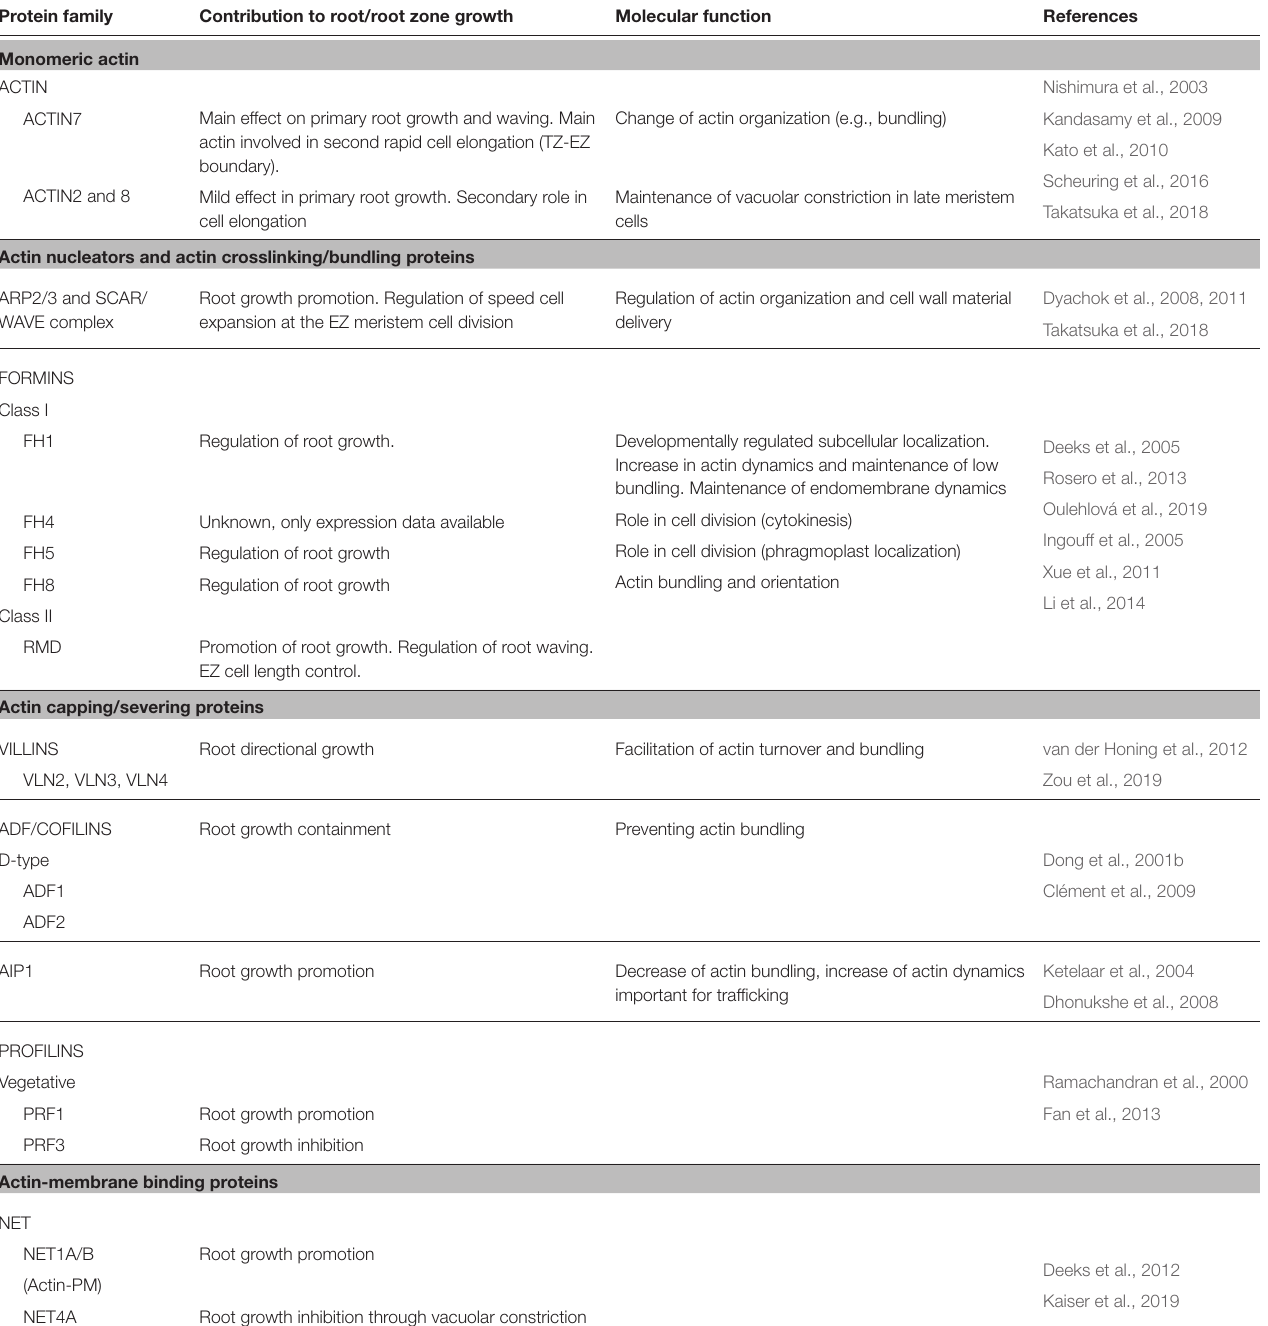
TABLE 2 | Actin and actin-binding protein role in primary root growth. Protein family Contribution to root/root zone growth Molecular